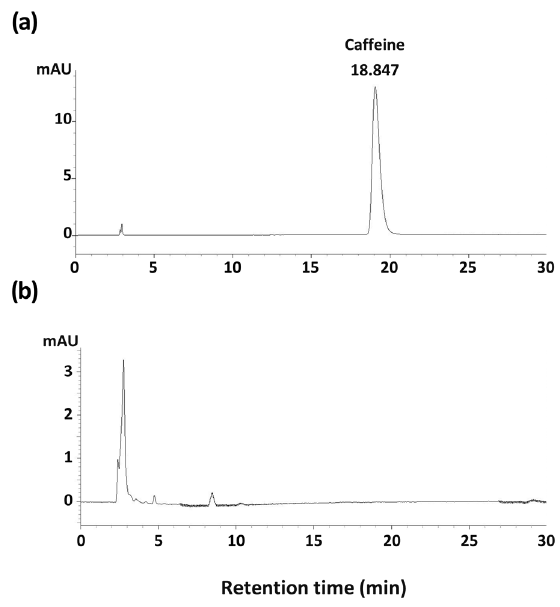
Figure 7. HPLC chromatogram of a caffeine reference standard ( a ) and GC ( b ). GC, G . cambogia peel extract.